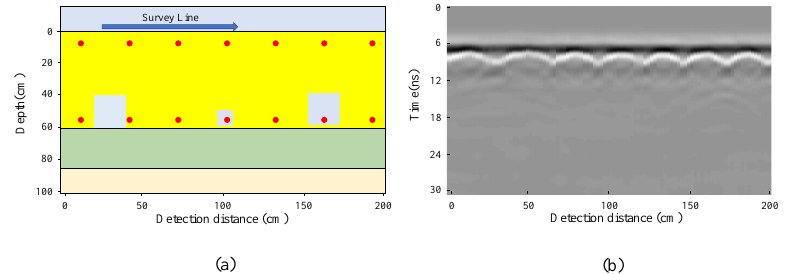
Figure 9. Laboratory model for real-world GPR data acquisition: ( a ) cross-section of the model and ( b ) collected raw GPR data.